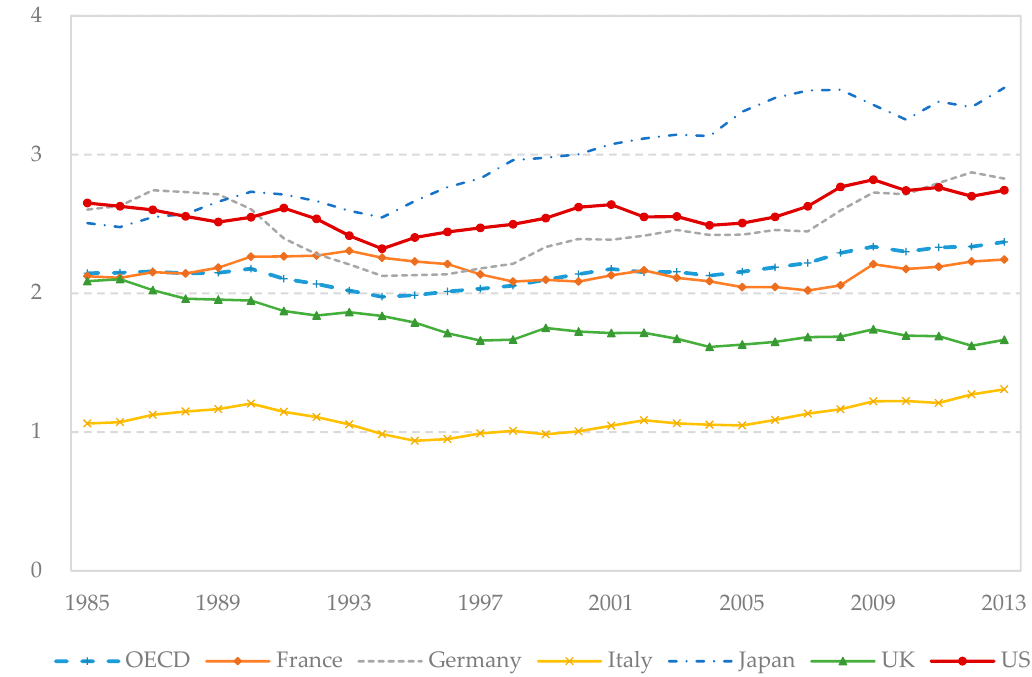
Figure 1. Research & Development (R&D) Intensity in Major Organization for Economic Cooperation and Development (OECD) Countries (OECD 2013).